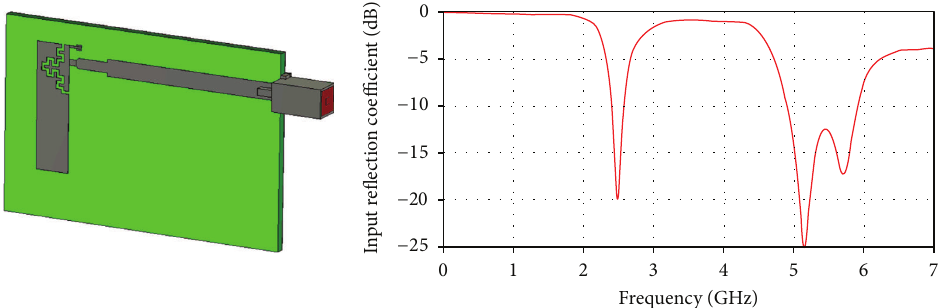
Figure 5: The computational model of the dual-band GK2 PIFA in perspective and the magnitude of its input reflection coefficient in the range DC-7GHz.